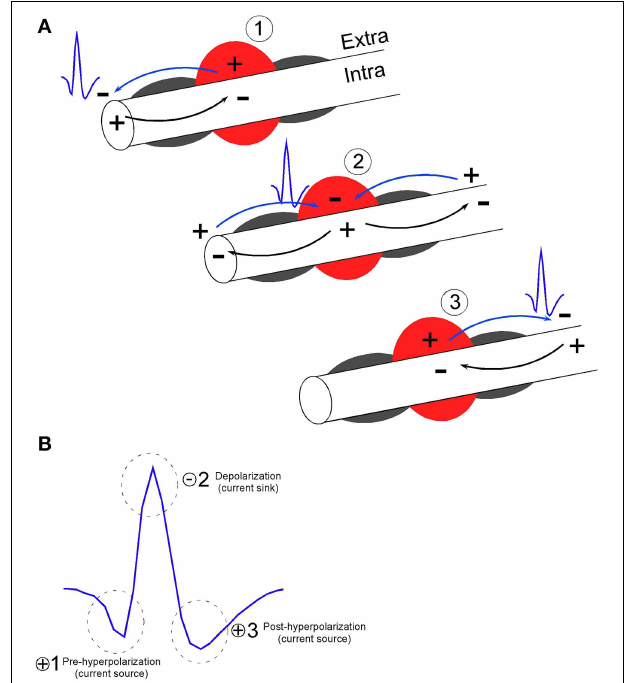
FIGURE 1 | Model of extracellular recording of action potential propagation along axons (Johnston and Wu, 1995) resulting in the triphasic shape of short duration waveforms. (A) At the point of action potential initiation on the left, local current will flow into the axonal membrane (Intra) and provide a current sink, while the point where the current exits the axonal membrane (Extra) provides a current source. If recordings are made near myelinated axons, current flow is likely generated at the nodes between myelinated segments (gray semi-circles surround the axon). Relative to a distant ground or reference electrode, the current sink generates the negative voltage potential while the source generates the positive voltage potential. As the propagating action potential passes the region of stationary electrode, (denoted by the red circle) the location of sinks and sources will change with time and alternate between a source (1), a sink (2) and a source (3). (B) The electrode will therefore record a triphasic waveform composed of a positive voltage potential indicating membrane hyperpolarization (1), a negative potential indicating membrane depolarization (2), and a positive voltage potential indicating membrane hyperpolarization (3). In reference to the depolarization phase (2), phase 1 and 3 are referred to as the pre and post hyperpolarization phase, respectively. The waveform therefore represents the movement of current flow in and out of the axonal membrane during the duration of the action potential. Example waveform has peak-valley duration of 0.150ms and signal to noise ratio of